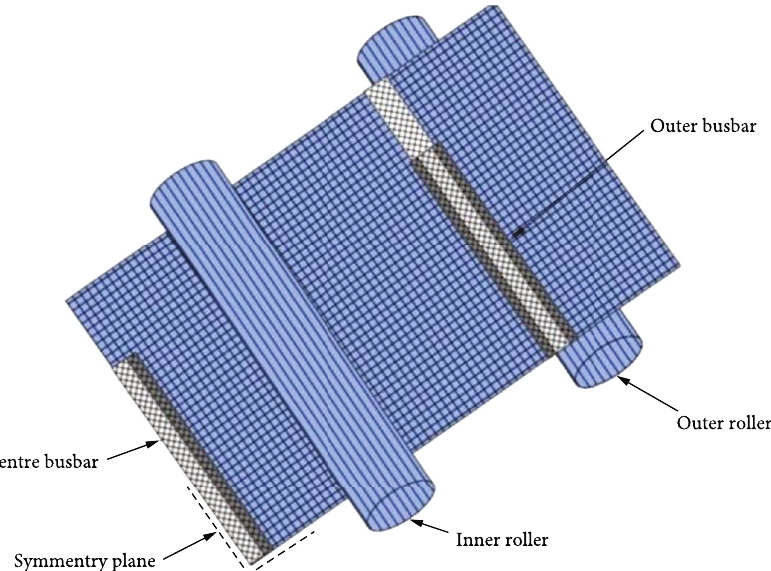
Figure 3: FEM model in quarter symmetry with mesh shell elements and di ff erent sections for di ff erent layers with busbars parallel to the roller.